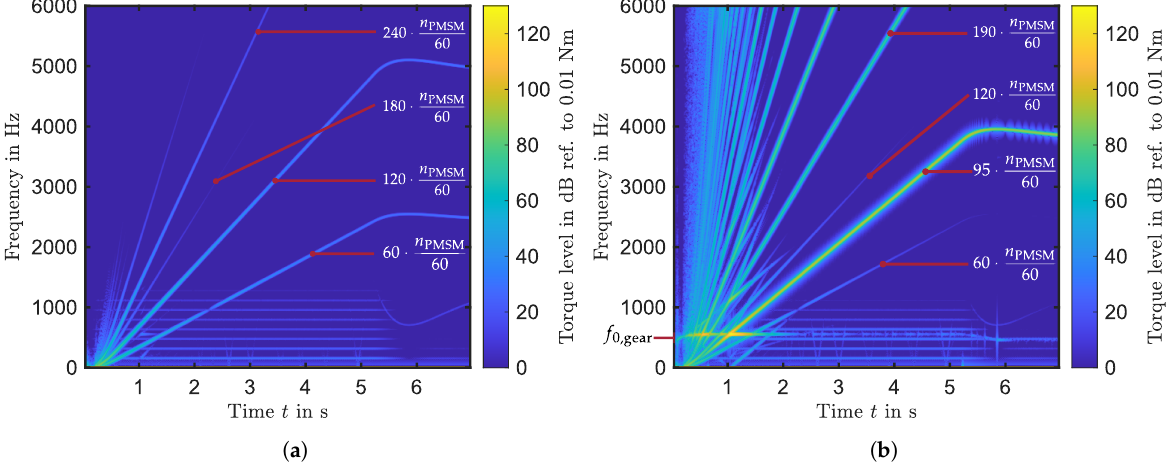
Figure 11. Results of the transient system model using the developed force element: ( a ) Spectrogram of the transient torque of the PMSM; ( b ) Spectrogram of the reaction torque at the carrier